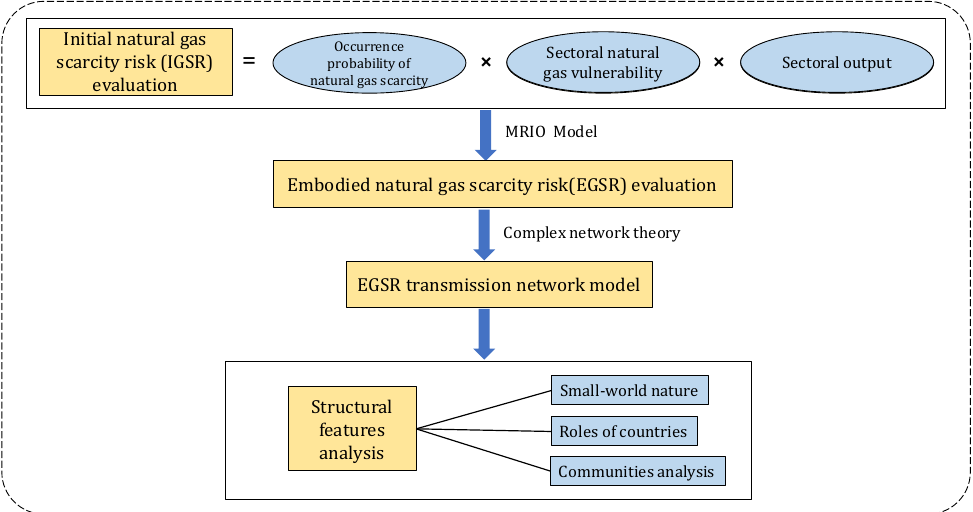
Figure 2. Framework of this